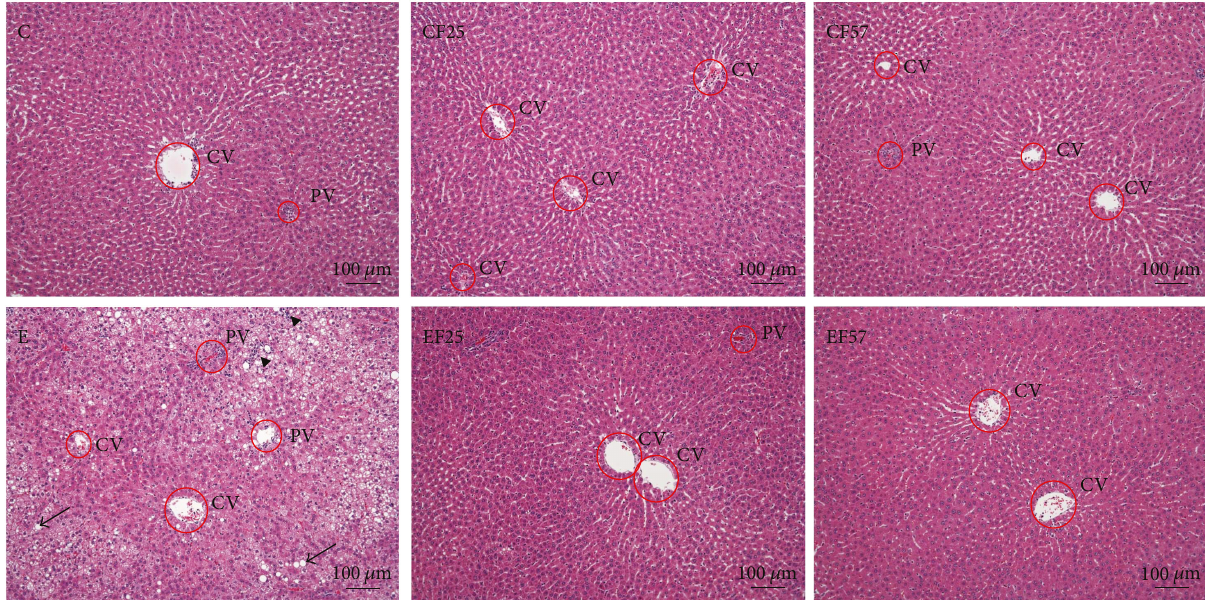
Figure 1: E ff ects of fi sh oil on H&E staining of liver tissue sections in rats with chronic ethanol feeding. CV: central vein; PV: portal vein; C: control group; CF25: control diet with fi sh oil substituted for 25% of olive oil; CF57: control diet with fi sh oil substituted for 57% of olive oil; E: ethanol group; EF25: alcohol-containing diet with fi sh oil substituted for 25% of olive oil; EF57: alcohol-containing diet with fi sh oil substituted for 57% of olive oil. H&E staining showed hepatocyte degeneration and necrosis accompanied by in fl ammatory cell in fi ltration (triangle) in group E. Moreover, fatty changes (arrow) were also found in group E. Table 4: Thiobarbituric acid-reactive substance (TBARS) concentrations in each group 1,2 . — F25 F57 Ethanol ∗ and fi sh oil